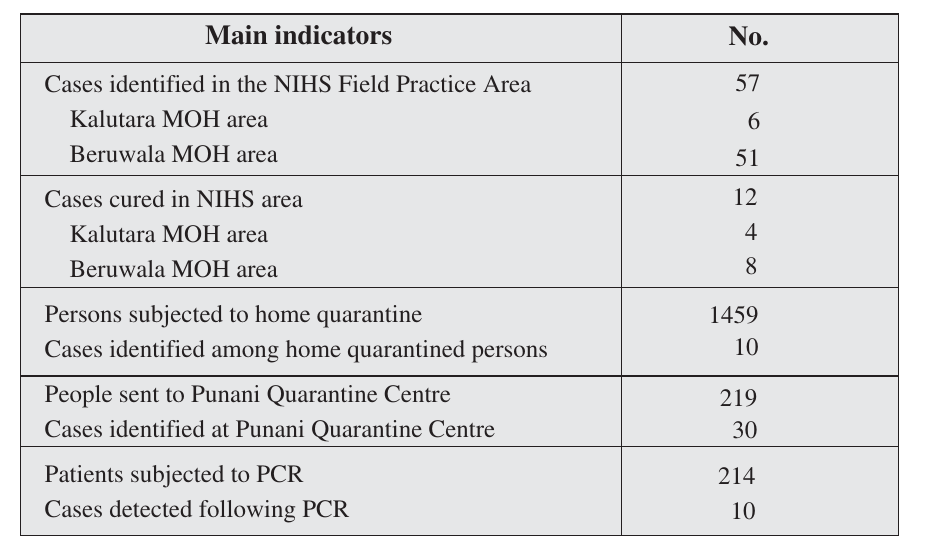
Table 1: Summary of the main indicators in COVID-19 management at NIHS Field Practice